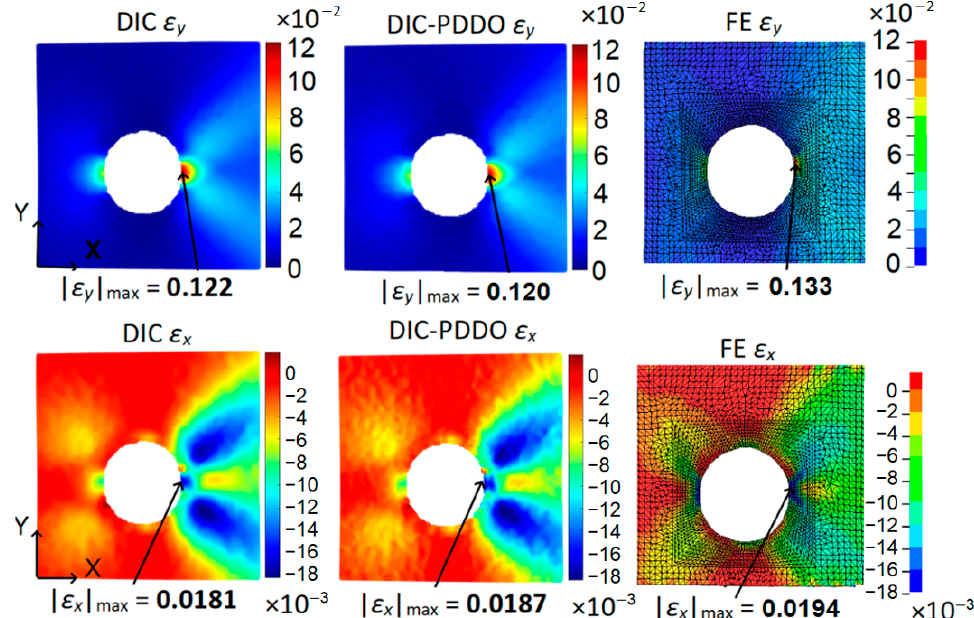
Figure 9. Comparison of ε y , ε x Lagrangian strains computed on tensile experiment specimen with DIC (VSG = 57 px), DIC-PDDO ( δ = 3.1 ∆ x , ∆ x = 0.167 mm) and FE simulation.